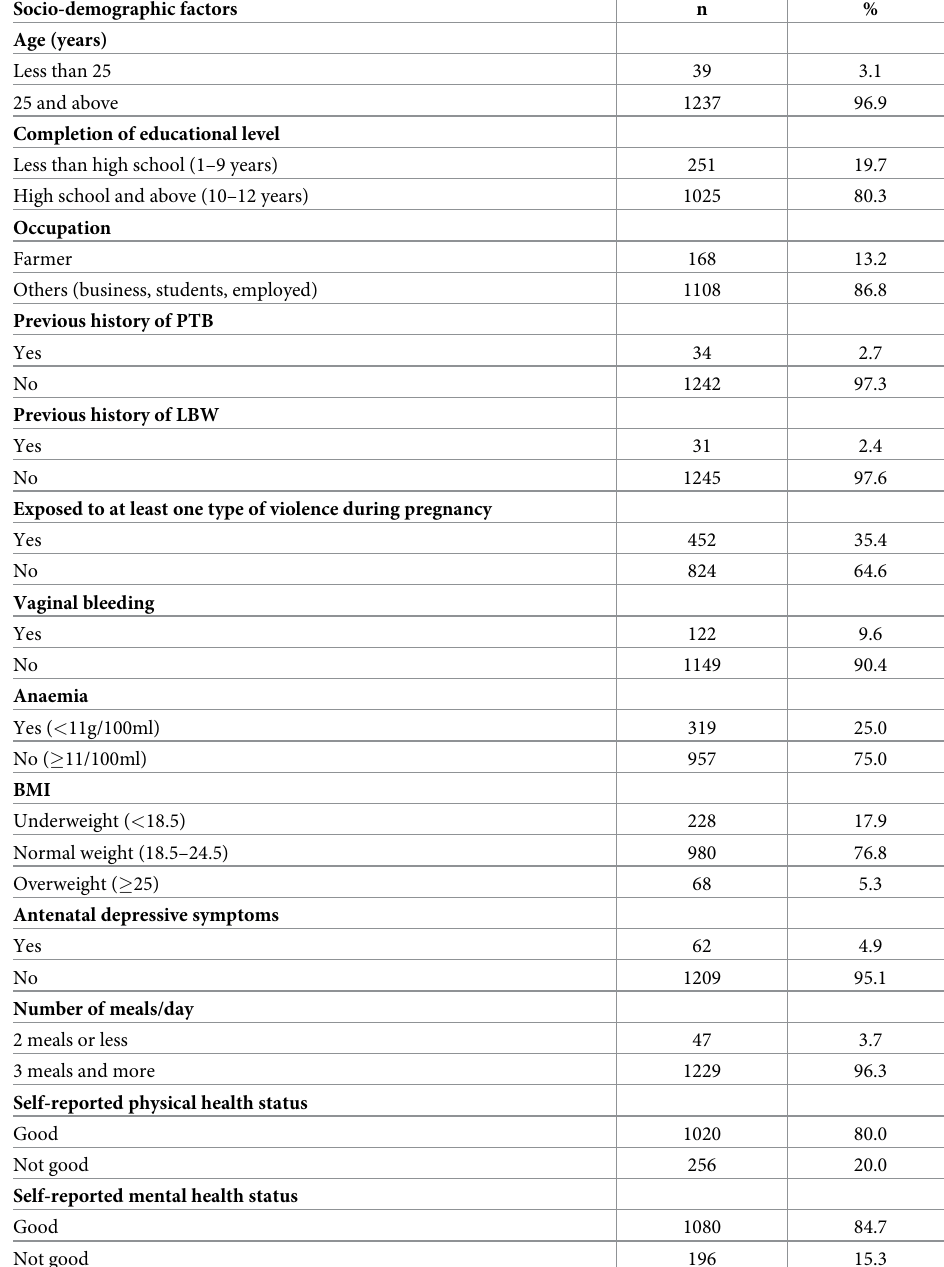
Table 1. Socio-demographic background of pregnant women (n = 1276). Socio-demographic